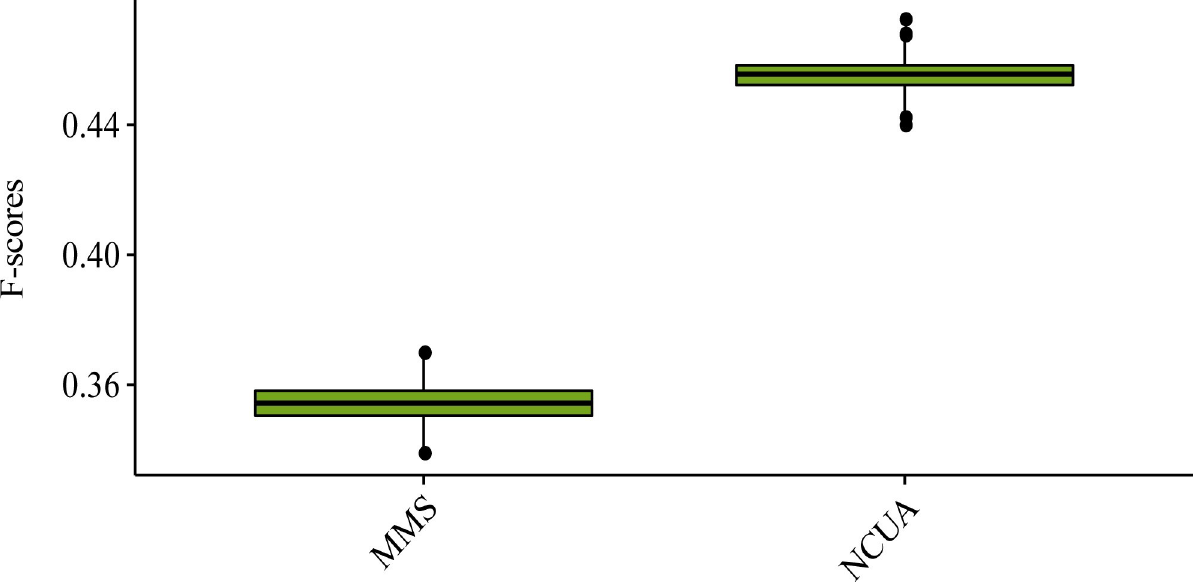
Fig 12. The F-score of the driver nodes’ enrichments in the list of cancer-associated genes in the human signaling network.